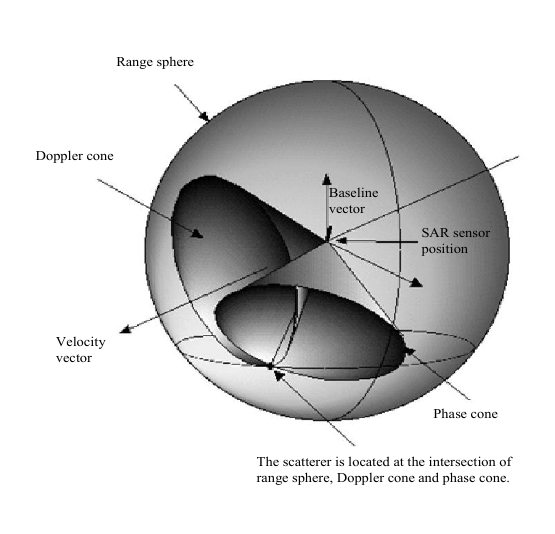
Figure 1. InSAR processing